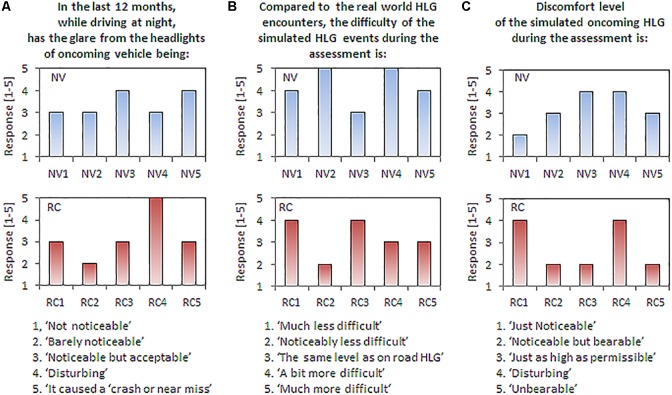
Responses to the questionnaires by normal vision subjects (top row) and patients with real cataracts (bottom row). The questions are shown on the top and scaled responses are shown on the bottom. (A) Perception of real-world HLG during nighttime driving. (B) Comparison of difficulty between the simulated and real-world HLG encounter events. (C) Discomfort level of the simulated HLG during the assessments.